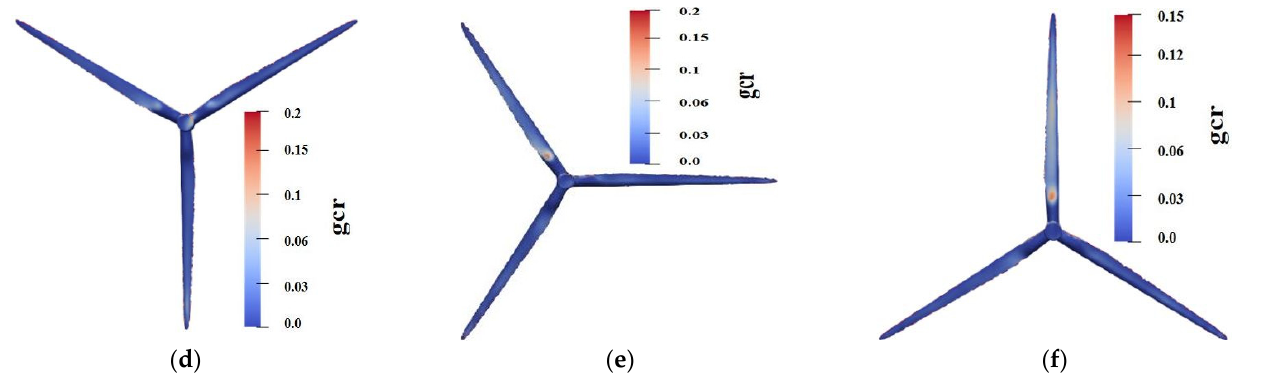
Figure 13. Rainwater distribution when V = 10 m/s; ( a ) front face of blade at 0°; ( b ) front face of blade at 30°; ( c ) front face of blade at6 0°; ( d ) back face of blade at 0°; ( e ) back face of blade at 30°; ( f ) back face of blade at 60°.